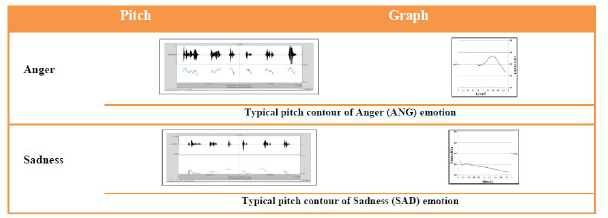
Fig. 6. European pitch contours for Anger and Sadness.